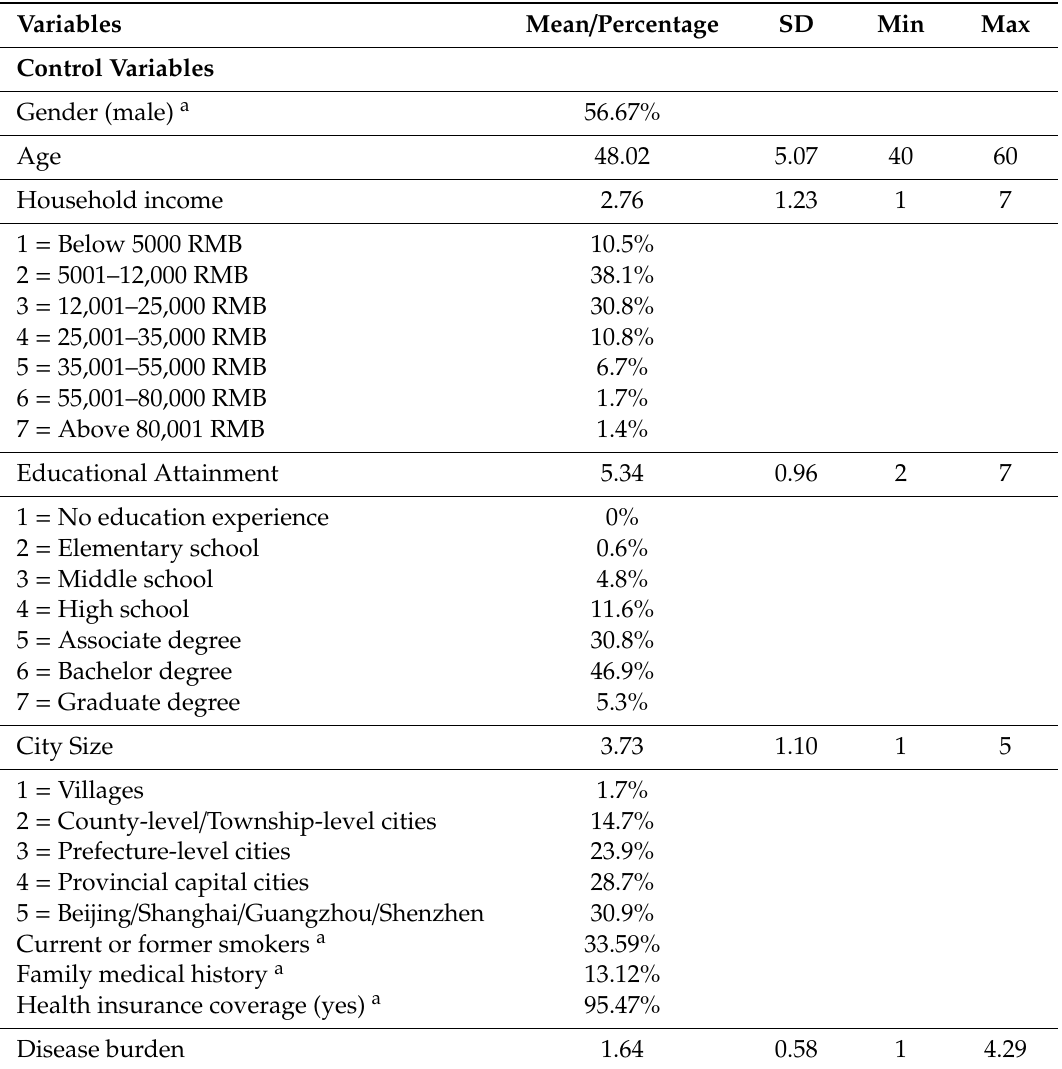
Table 1. Descriptive Statistics (N =